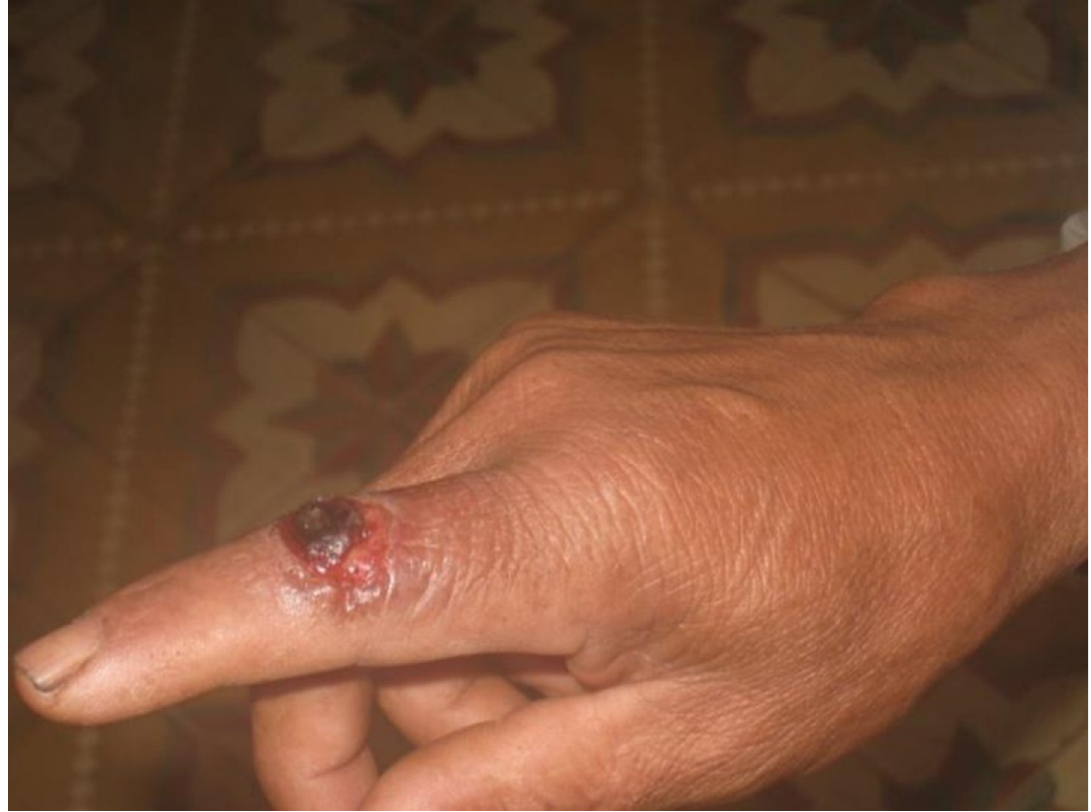
Fig 2. The affected finger of a cutaneous anthrax patient. A typical black eschar on the finger of a cutaneous anthrax patient who had a history of contact with B . anthracis -infected animals and carcasses.